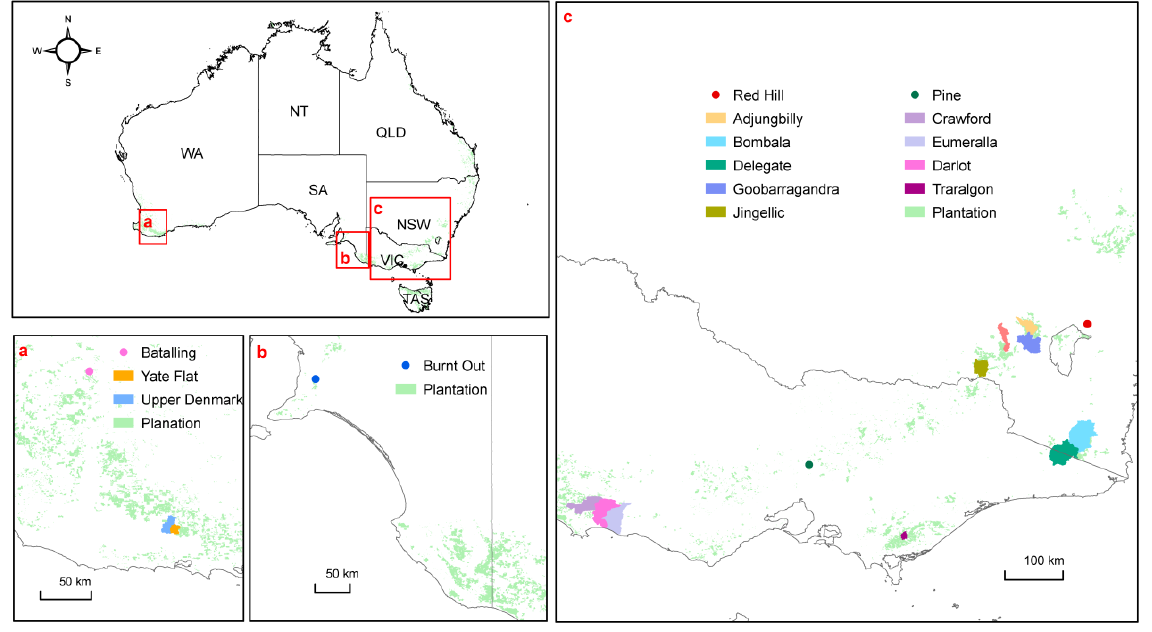
Figure 3. Location map of the catchments. 2 Fig. 3. Location map of the